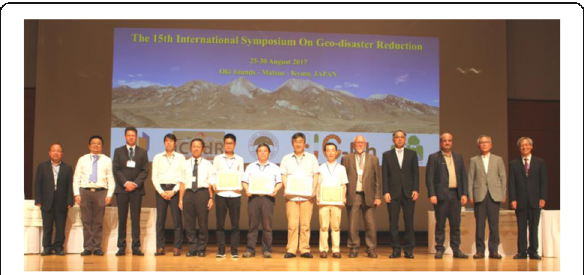
Fig. 6 Group photo of the ICGdR Awards winners